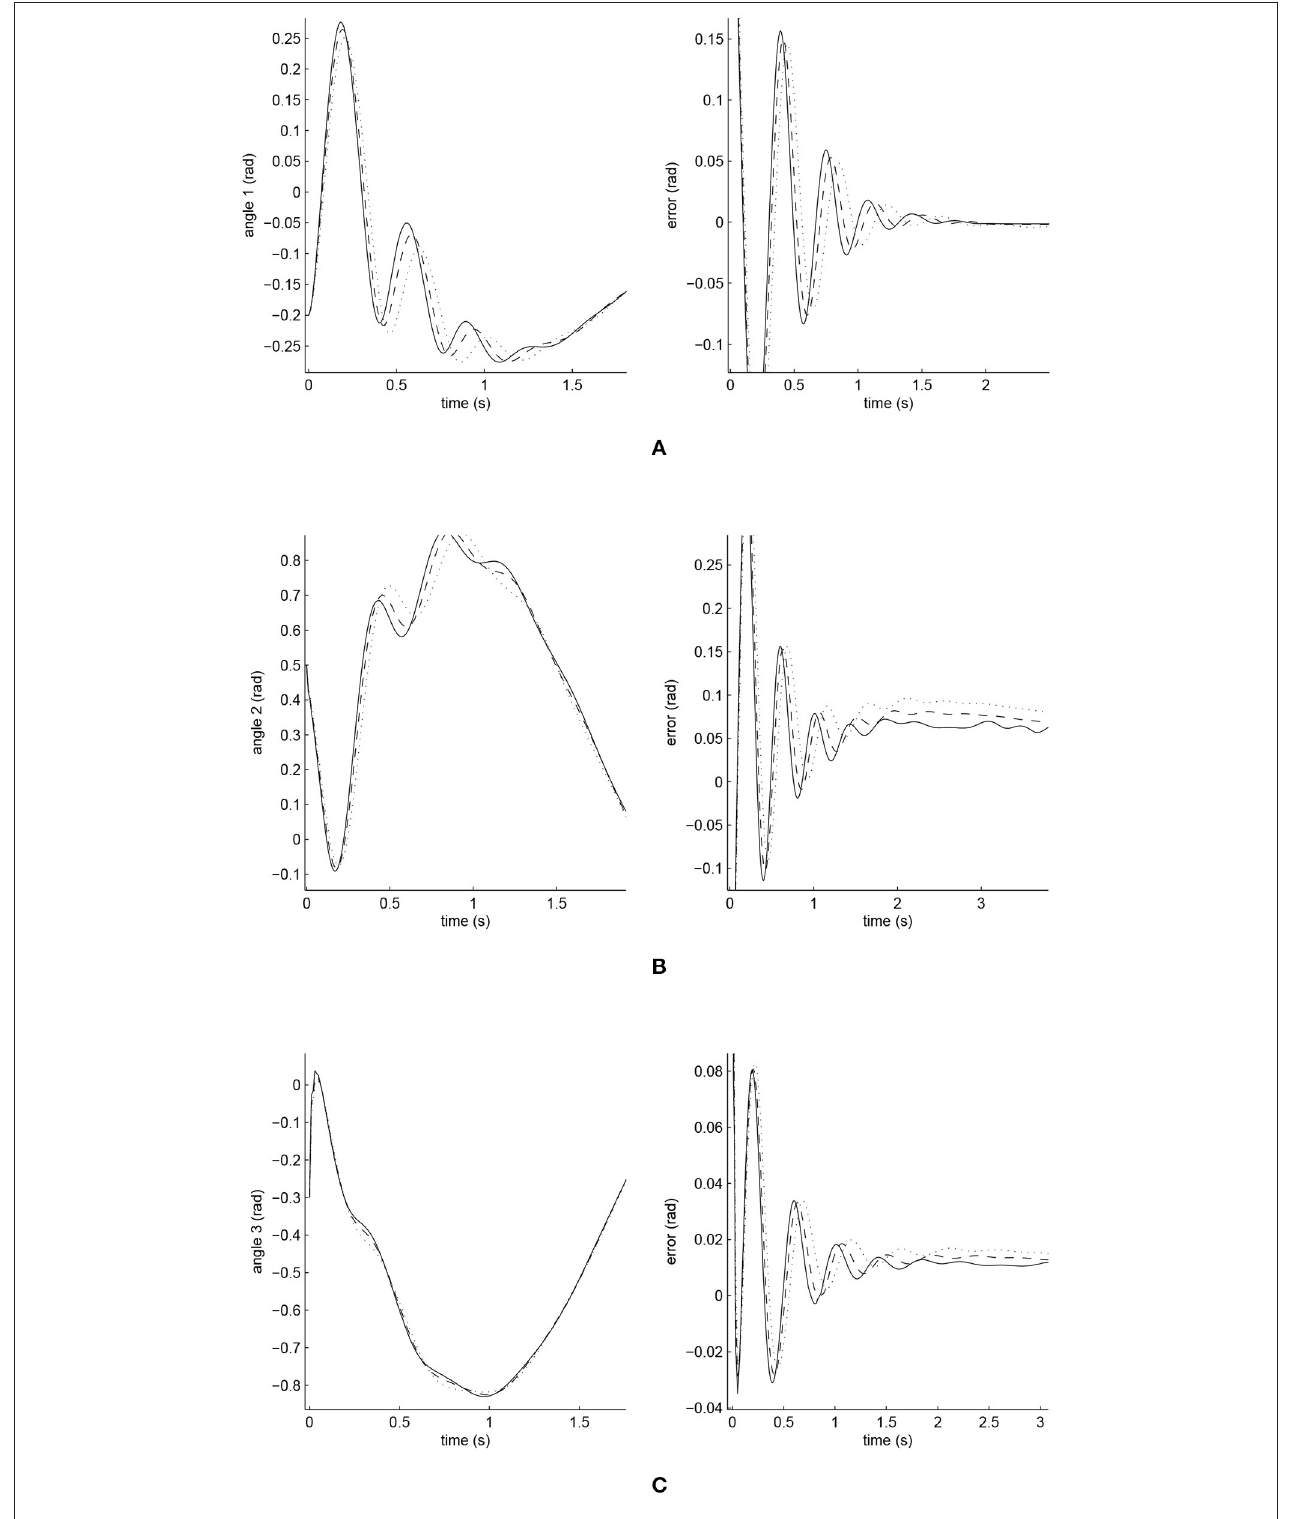
FIGURE 6 | Amplified trajectory responses (in the left) and tracking errors (in the right) at t = 0 of Joints 1, 2, and 3. The solid line indicates the performance of the iFBEL; the dotted line represents that of the PID controller; and the dot dash line implies that of the FCMAC controller. (A) Amplified trajectory response and tracking error of Joint 1. (B) Amplified trajectory response and tracking error of Joint 2. (C) Amplified trajectory response and tracking error of Joint 3.